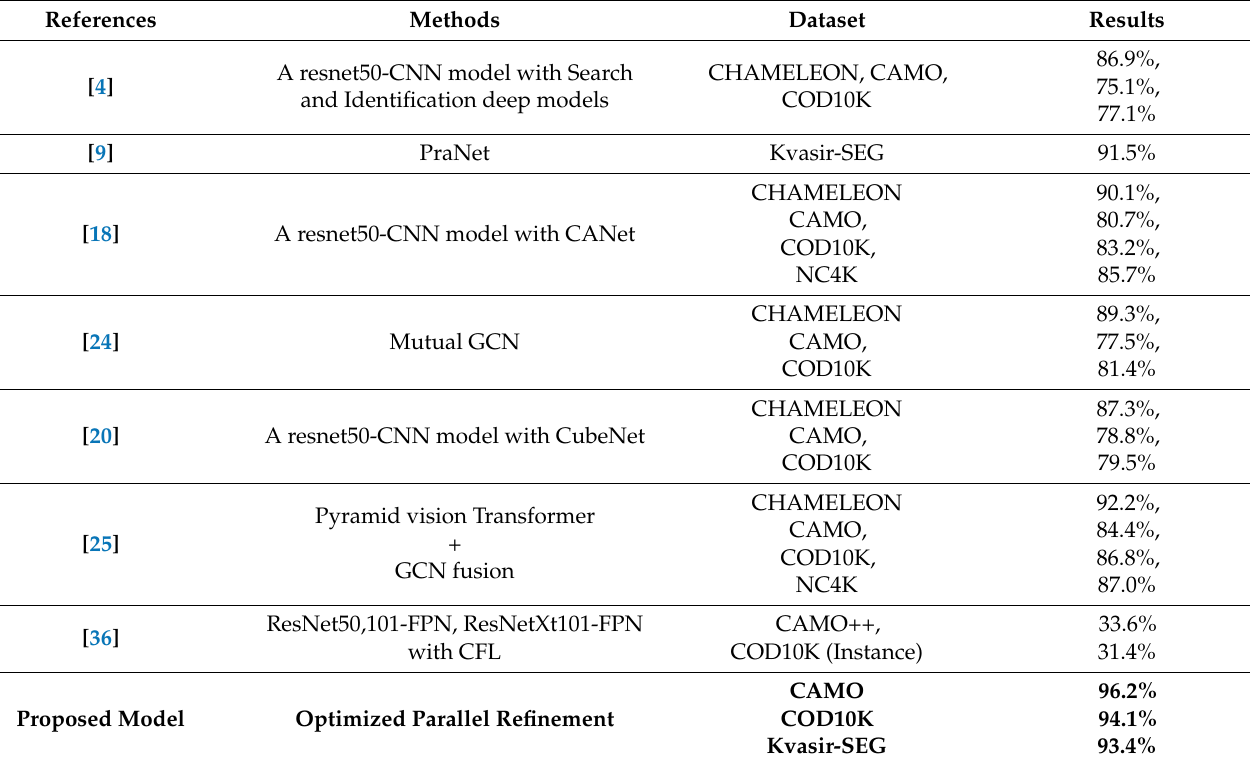
Table 3. Comparison of different state-of-the-art methods, datasets, and their